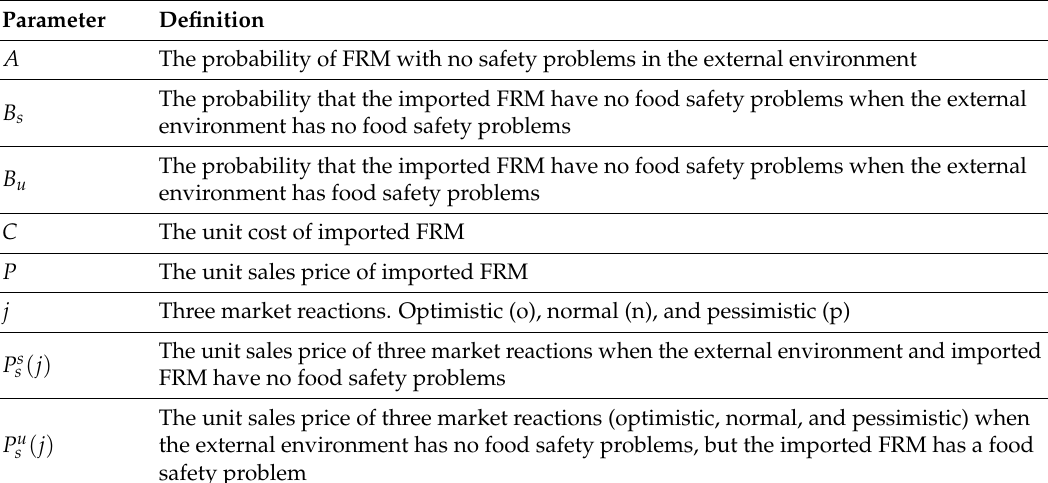
Table A1. Parameter